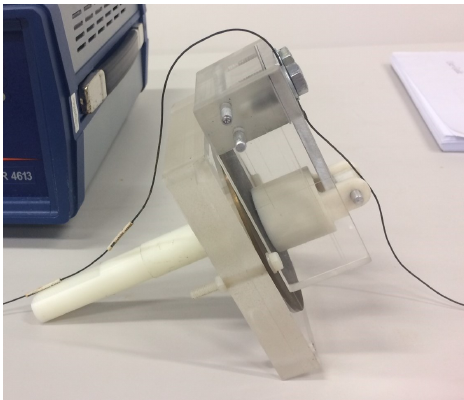
Figure 11. Fixture comprised of an acrylic plate and a nylon rod holds the steel disc with a sensor